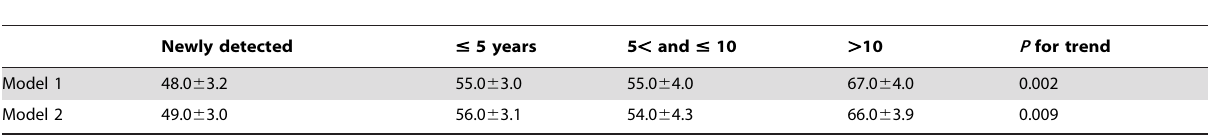
Table 4. Weighted prevalence (%) of lens opacity in diabetic patients by diabetes duration.